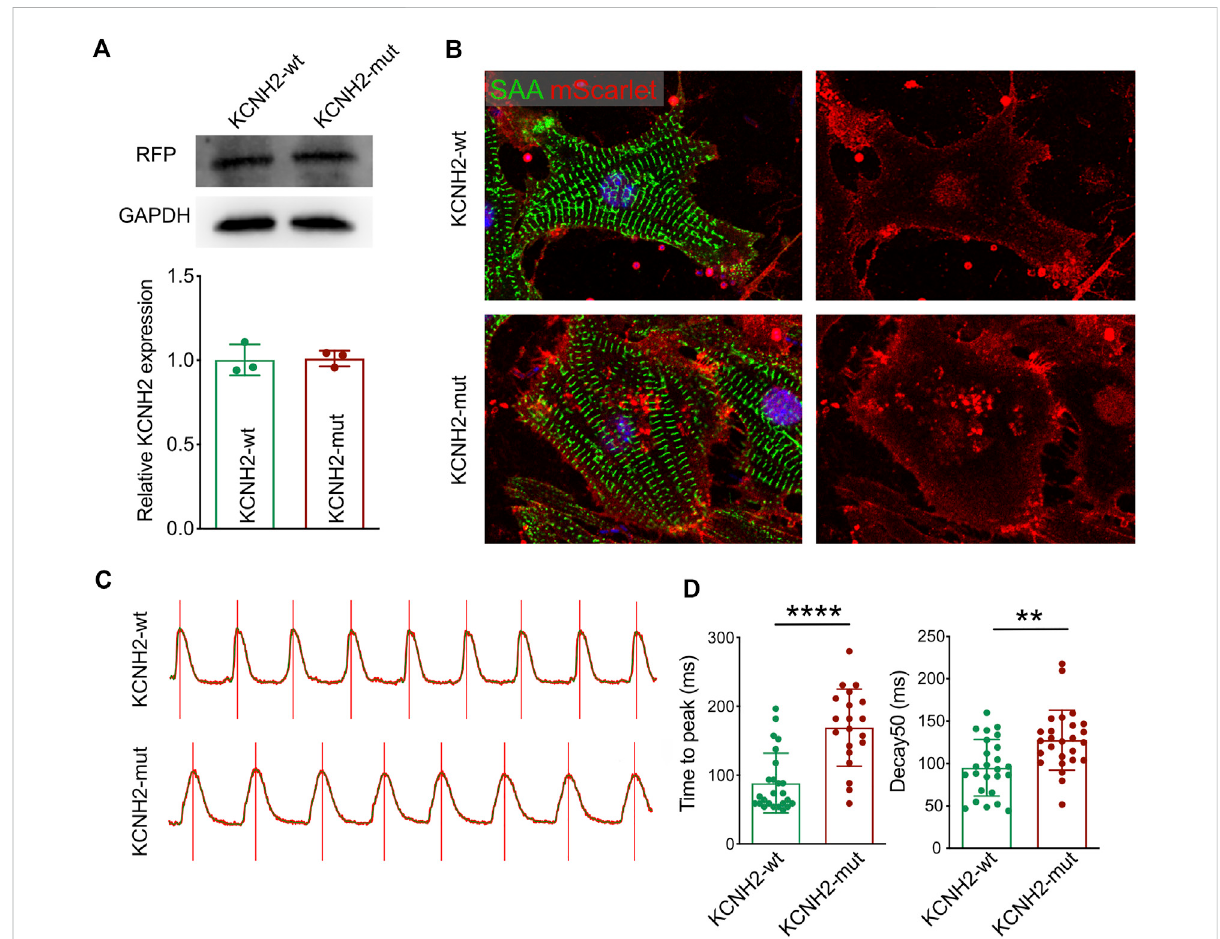
FIGURE 4 Functional validation of KCNH2 c.1868C > A mutation on cardiomyocyte. (A) Western blotting demonstrated the similar expression of KCNH2 protein between wild type and mutation. (B) Immuno fl uorescence staining revealed the successful infection of KCNH2 overexpression plasmids in cardiomyocytes. (C) Calcium transit waves between KCNH2-wt and KCNH2-mut plasmids transfected cardiomyocytes. (D) The increased duration oftime to peak anddecay50 wasidenti fi edinKCNH2-mut cardiomyocytes.RFP, red fl uorescence protein;SAA,sarcomeric α -actinin. **, p < 0.01; ****, p <